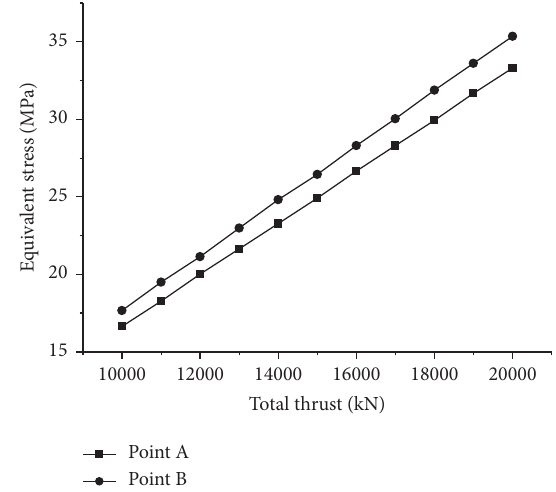
Figure 14: Correspondence between equivalent stress and front total